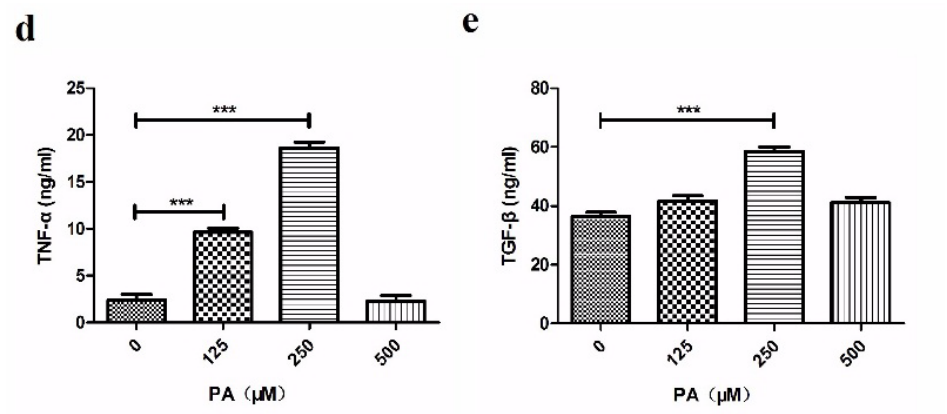
Figure 1. The expression of TLR4, TRAF6, TNF-α and TGF-β in THP-1 after PA exposure. ( a ) THP-1 cells transfected with NF-κB luciferase reporter vector were exposed to different concentrations of PA for 8 h, and the relative luciferase intensity between different groups was detected; ( b ) THP-1 cells were exposed to 250 μM PA for 8 h. Semi-quantitative PCR analysis the mRNA expression of TLR4, TRAF6, TNF-α, TGF-β and LPS is positive control; ( c ) The protein levels of TLR4 and TRAF6 in the THP-1 cells, LPS as a positive control; ( d , e ) Supernatants from THP-1 exposed to different concentration PA for 8 h were collected to measure TNF-α and TGF-β by ELISA. Results are mean ± SD. * p < 0.05 and ** p < 0.01, *** p <